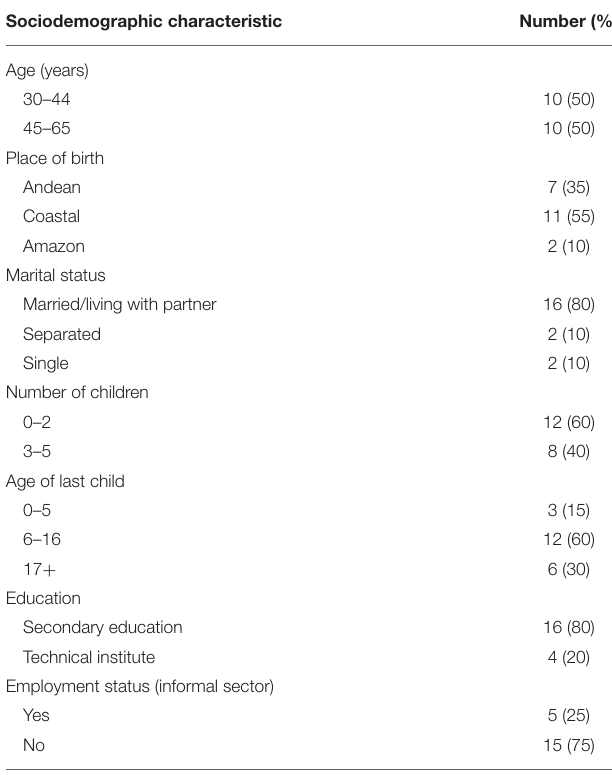
TABLE 1 | Characteristics of the interview participants ( N =